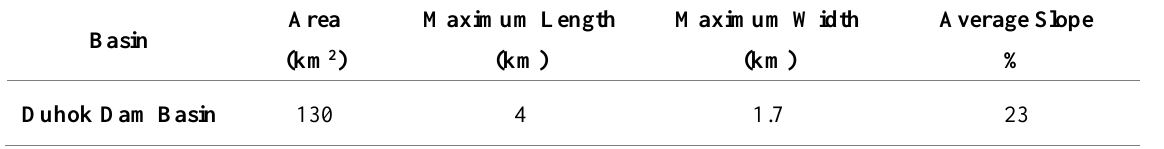
Table 1 . Show some morphometric properties Duhok dam basin